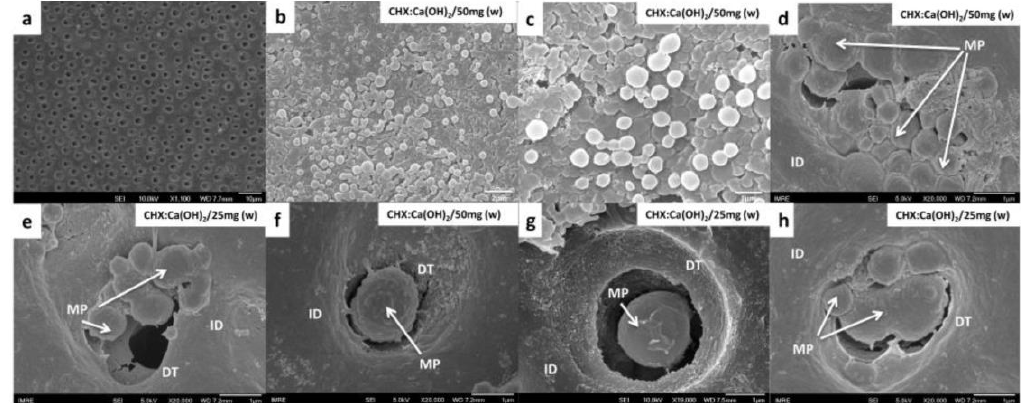
Figure 7. ( a ) Representative SEM image of the ultra-high polished specimens showing the dentinal tubules structure of the deep dentin (scale: 10 µ m). ( b , c ) Selected SEM images, at different magnifications, showing the formation of an intact layer of evenly-distributed spherical microparticles attached and covering the prepared dentin surface (scale: 2 µ m and 1 µ m respectively). This indicates successful attachment of microparticles on the exposed dentin-surfaces. ( d – g ) Selected high magnification SEM images, at different magnifications, showing the ability of the microparticles to seal the open dentinal-tubules of the ultra-high polished dentin-surface (scale: 1 µ m). ( h ) SEM image showing the dentinal tubule occlusion of microparticles in the absence of micro-brushing and air-blowing procedures.